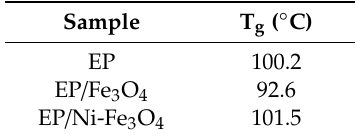
Table 1. T g of the fully cured neat epoxy and its nanocomposites at β of 10 ◦ C /